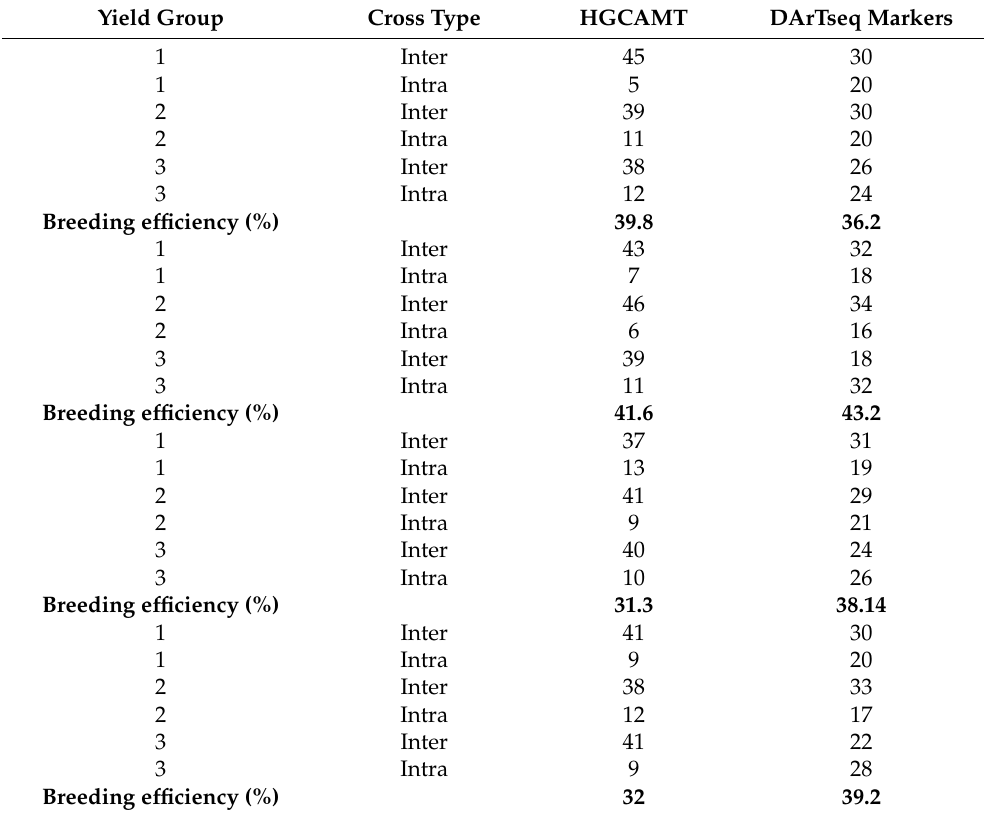
Table 4. Breeding efficiencies of the heterotic group’s general combining ability of multiple traits and the DArTseq marker methods under combined heat and drought, heat, terminal, and across drought environments. Yield Group Cross Type